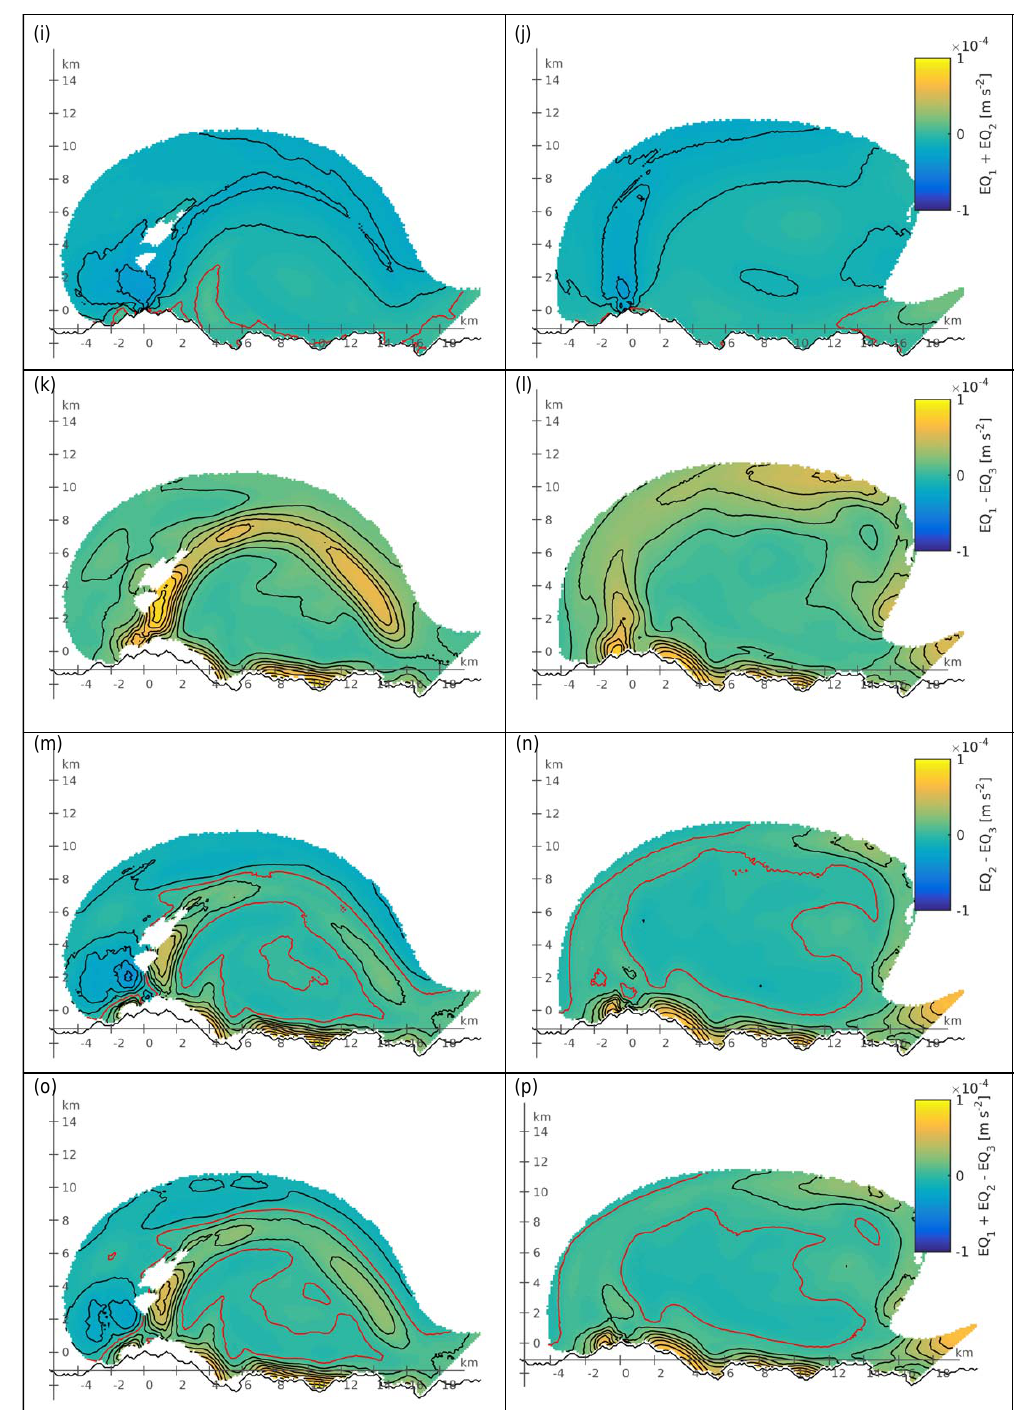
Figure 8. Bulge depth and depth averaged velocities, the terms ( T 1 , T 2 , T 3 ) of the balance (see Eq. 3) and the combinations of the terms for idealized (left column) and realistic (right column) model simulations on 29 March 2007 at 20:00. Bulge depth and depth averaged velocities (a–b) , centrifugal term ( T 1 ) (c–d) , Coriolis term ( T 2 ) (e–f) , pressure gradient term ( T 3 ) (g–h) , T 1 + T 2 (i–j) , T 1 − T 2 (k–l) , T 2 − T 3 (m–n) and T 1 + T 2 − T 3 (o–p) . The contour interval is 1ms − 2 . The red isoline represents zero. The blank area within the bulge is where the tracer concentrations were below the threshold values of the bulge definition (see text for bulge definition). The origin of the coordinate system is at the mouth of the Daugava River. True north is shown with the arrow